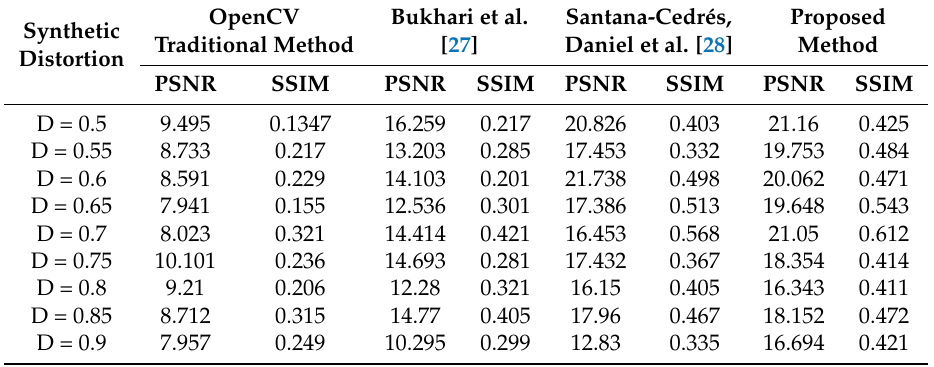
Table 4. PSNR and SSIM metrics for various methods on synthetic distortions on KITTI dataset. Synthetic